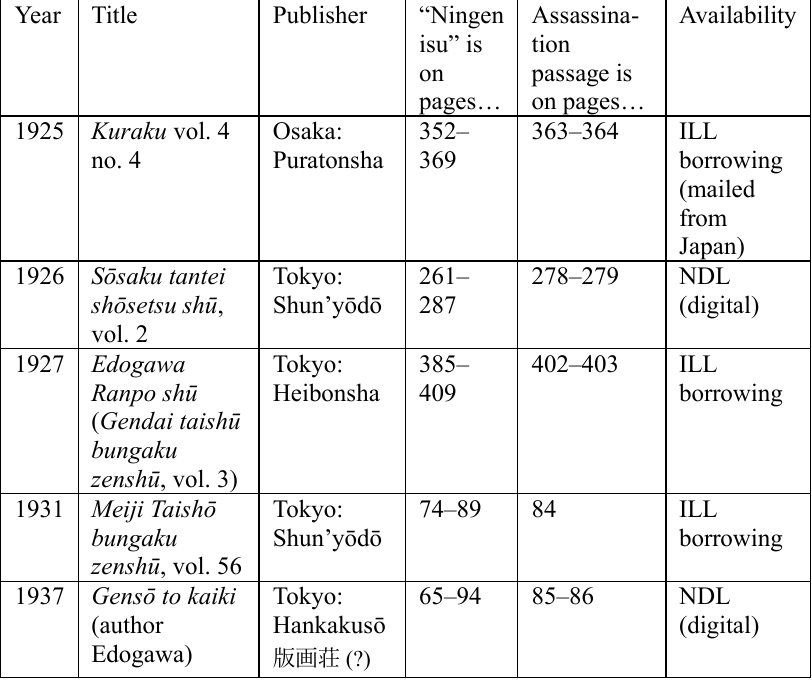
Table 1. Pre-1956 Versions of “Ningen isu”